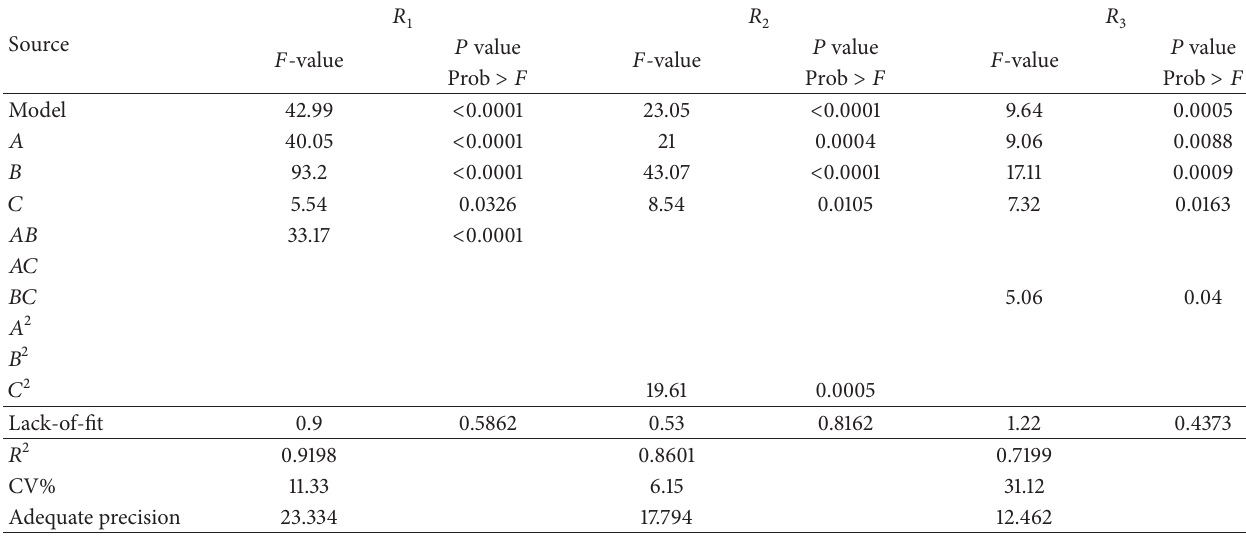
Table 2: The analysis of variance (ANOVA) for the fitted models.